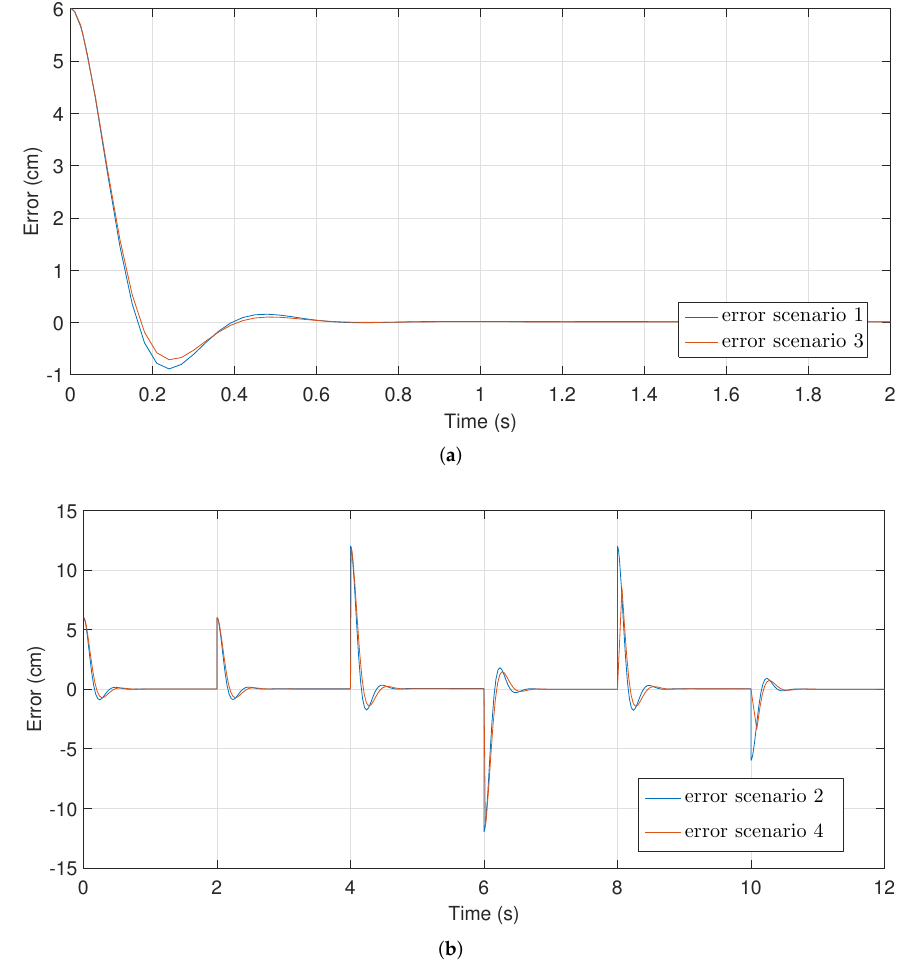
Figure 9. Errors obtained by the experimentation platform. ( a ) Errors for scenario 1 and 3; ( b ) errors for scenario 2 and 4.